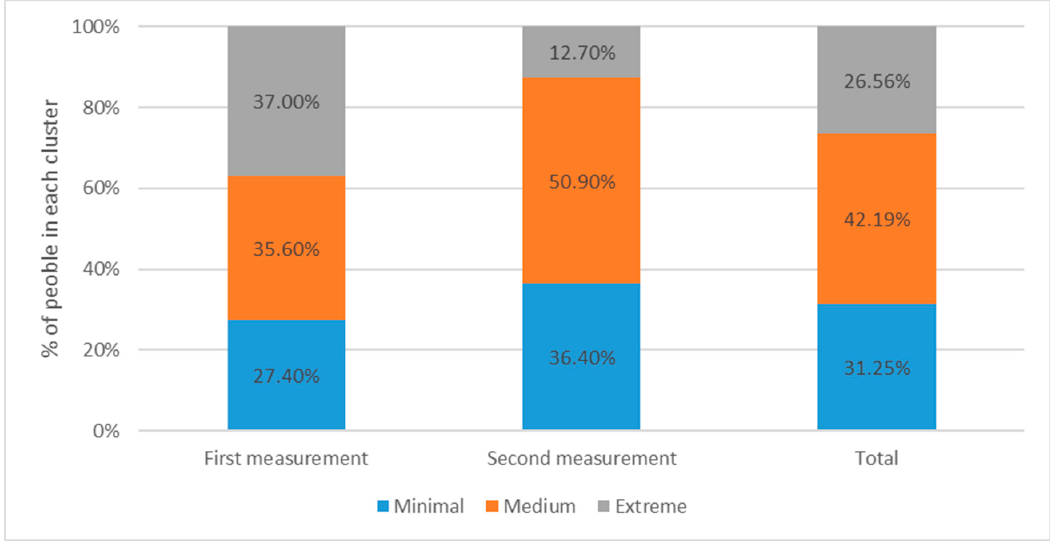
Figure 3. Measurement-based segmentation.